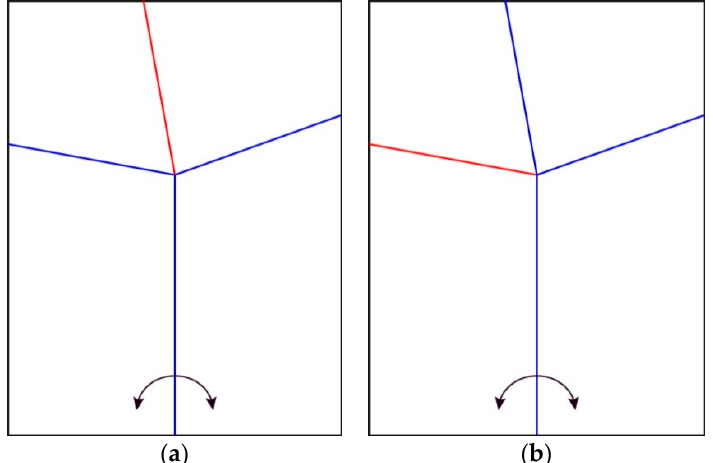
Figure 1. Unfolded pattern based on the drawings from Haas and Wootton’s abstraction of insect wings [9]. ( a ) and ( b ) display the two different ways of folding this pattern. The blue and red lines represent valley and mountain folds, respectively, knowing that these folds can also be inverted. The arrows at the bottom show the actuation angle to fold and unfold this pattern.